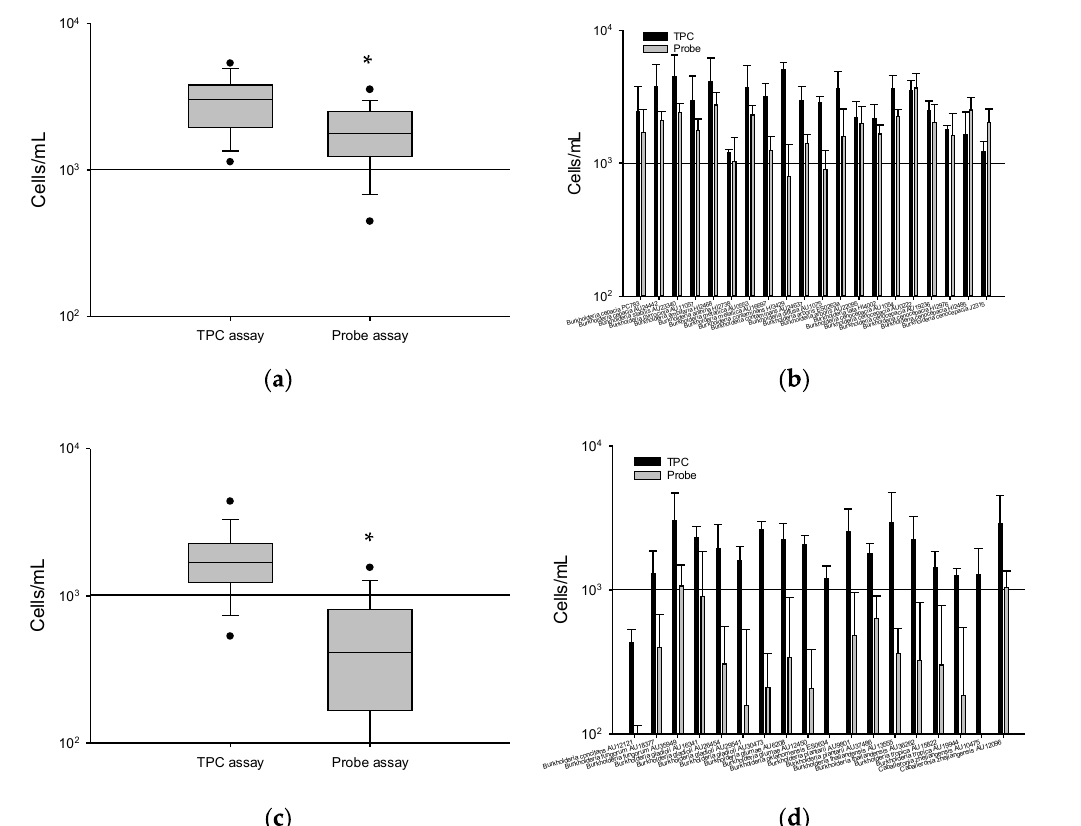
Figure 2. Comparison of specificity of Kef probe for 100 CFU/mL of 20 BCC strains ( a , b ) and 18 non- BCC strains ( c , d ) using flow cytometry. * Indicates statistically significant differences from TPC ( p < 0.001). Statistical analysis was performed via a paired t-test using SigmaPlot vs. 13.0 software. See Figure 1 for